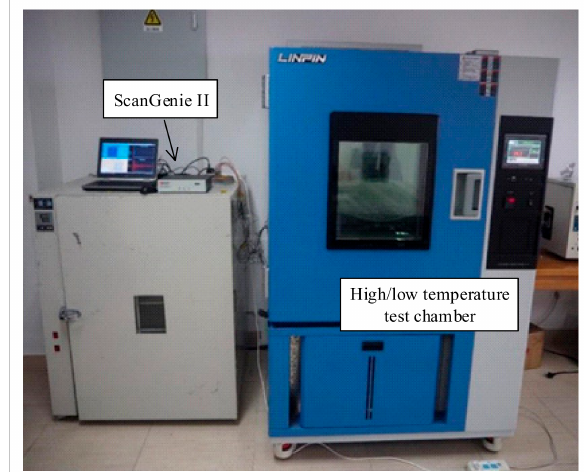
Figure 12. Experimental set